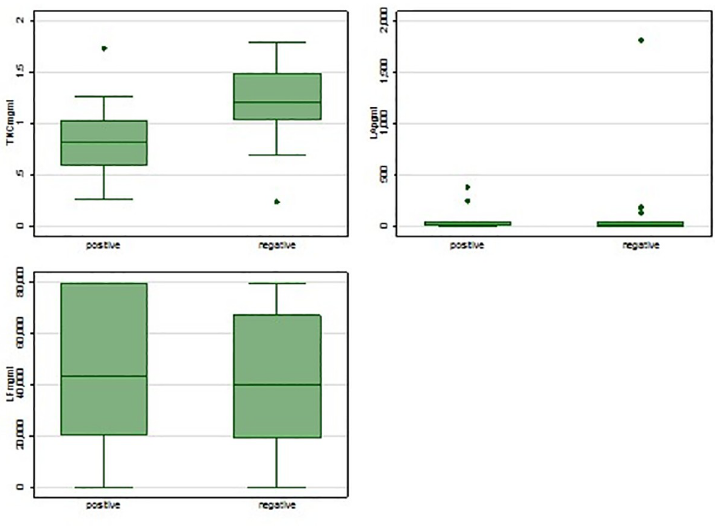
Fig 5. Distribution of breastmilk components concentration (lactoferrin, lactadherin and tenascin-C) by mother’s HIV status.